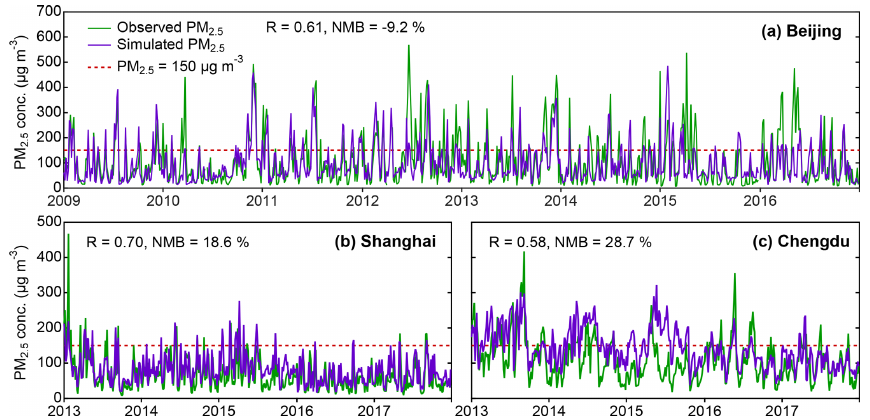
Figure 3. Simulated (purple solid line, from CTRL simulation) and observed (green solid line, from the US embassy and CNEMC) daily mean surface-layer PM 2 . 5 concentrations (µgm − 3 ) for grids of (a) Beijing, (b) Shanghai, and (c) Chengdu over the period when observations are available. Also shown are the threshold of PM 2 . 5 = 150µgm − 3 (red dashed line), the correlation coefficients ( R ), and NMB values between observed and simulated daily mean PM 2 . 5